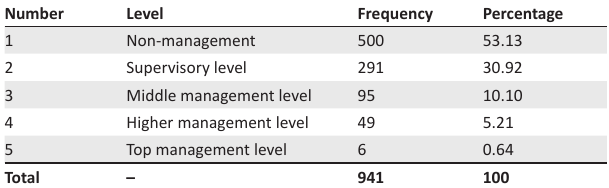
TABLE 2: Management level